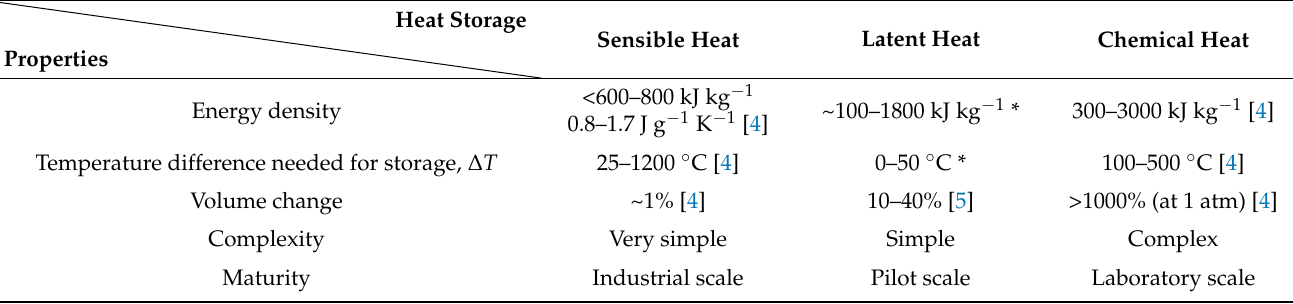
Table 1. Comparison of the different heat storage